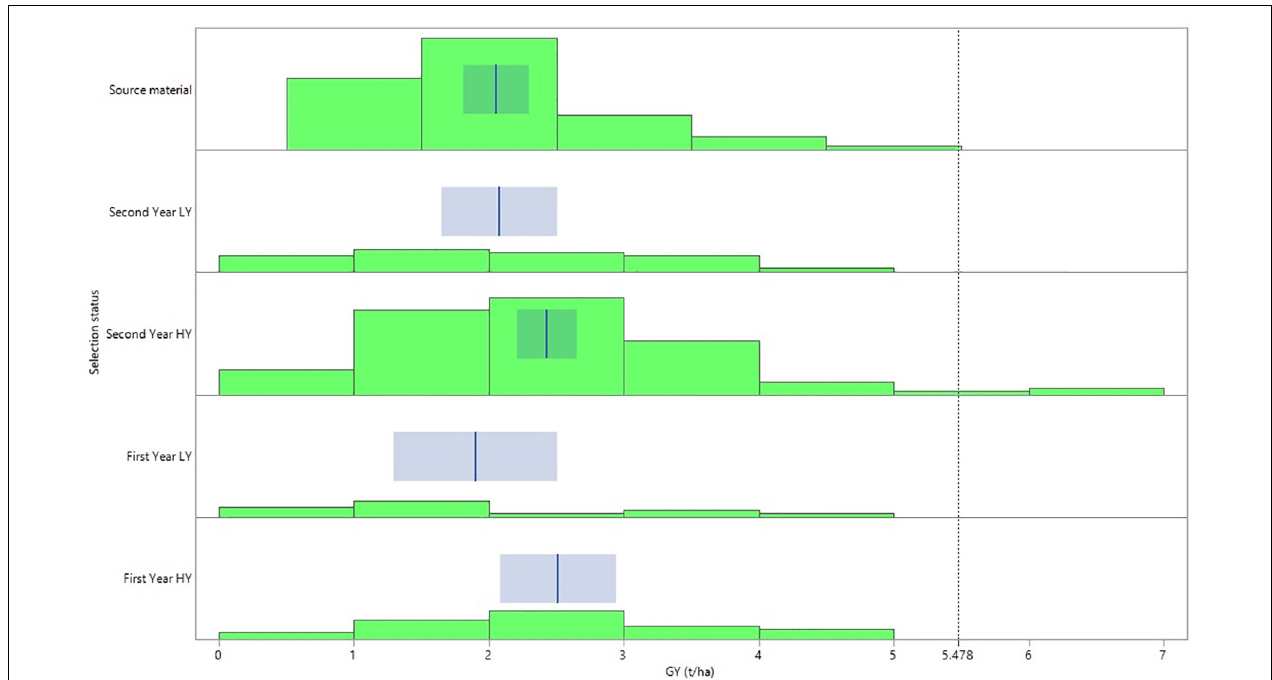
FIGURE 2 | Distribution graph and fit of means for grain yield performance according to the selection status of the barley lines evaluated under dense stand trials in three environments in Tunisia.